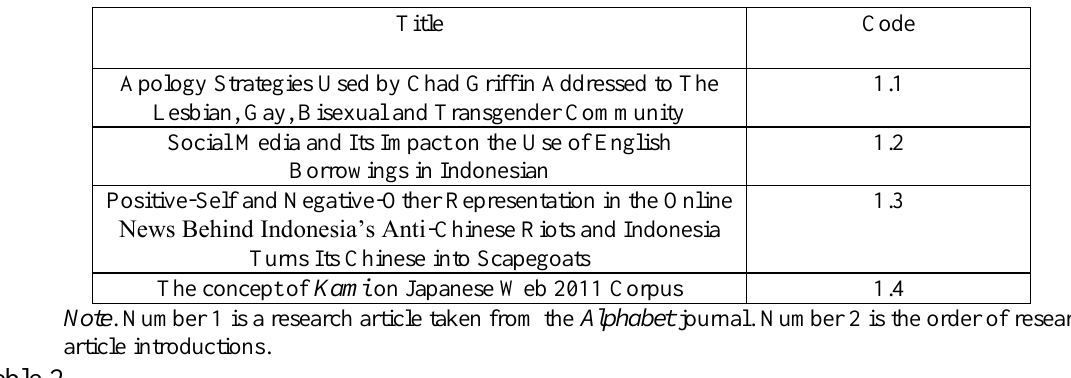
The list of the three research articles Title Code The Effectivity of Reog Dance in Learning Bahasa Indonesia for BIPA Students in Universitas Brawijaya. Course Evaluation of Customs English Club (CEC) in Customs Excise Office Blitar. Code-Switching Used by Sacha Stevenson in Talk Shows. .